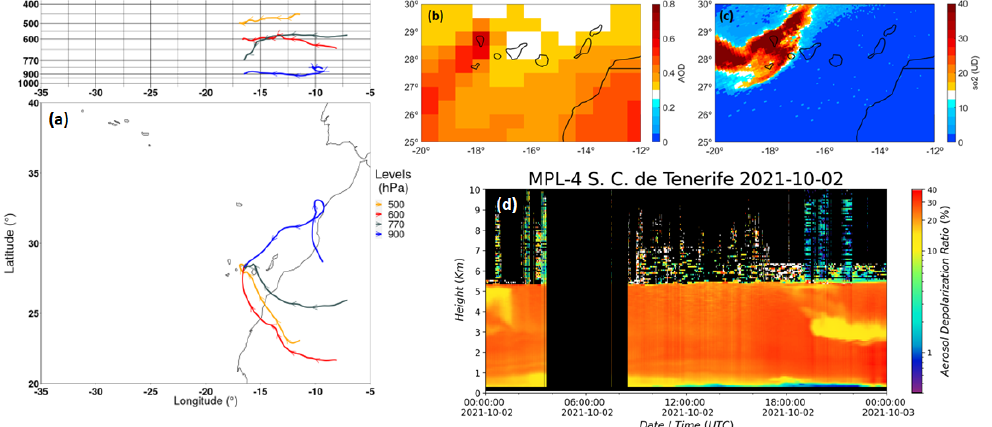
Figure 3. Backward minus trajectories (72 h), ending point at the IZO at 12:00 UTC from FLEXTRA using ERA5 reanalysis at four pressure levels (900 (blue line), 770 (black line), 600 (red line), and 500 (orange line) hPa). ( b ) Daily average MERRA-2 AOD at 550 nm on 2 October 2021. ( c ) Satellite SO 2 total columns from Copernicus Sentinel-5P TROPOMI over the Canary Islands on 2 October 2021. ( d ) Aerosol depolarisation ratio ( δ aer ) determined from the MPL at 532 nm at the